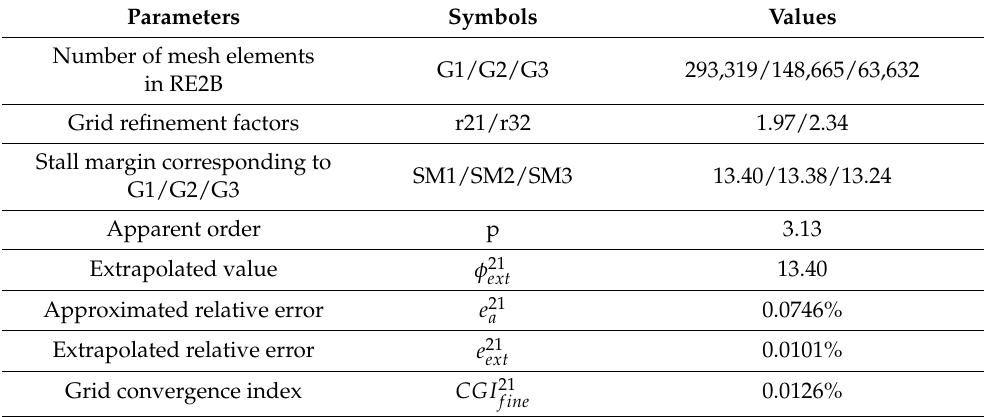
Table 2. CGI analysis results for the grid in